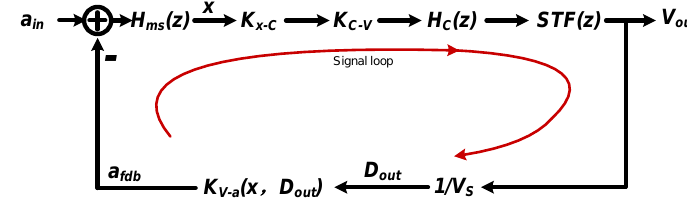
Figure 4. The signal flow diagram of the signal